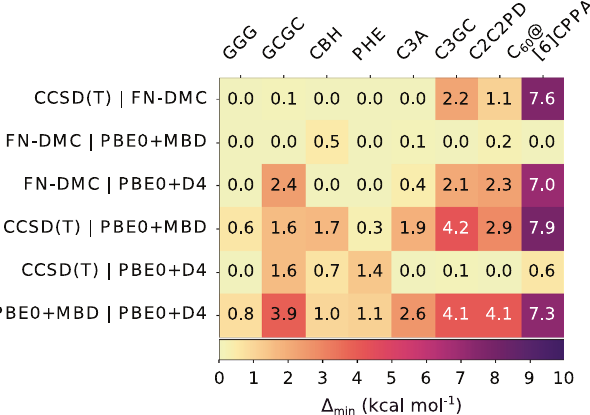
Fig. 5 Δ min is shown between pairs of methods. Δ min takes into account the error estimates for CCSD(T) and FN-DMC to show smallest differences with respect to these reference methods. The DFT methods have no quanti fi ed uncertainty estimates associated with them. The compared methods are: CCSD(T), FN-DMC, PBE0 + MBD and PBE0 + D4. The supramolecular complexes are those in the L7 data set and the C 60 @[6] CPPA buckyball-ring